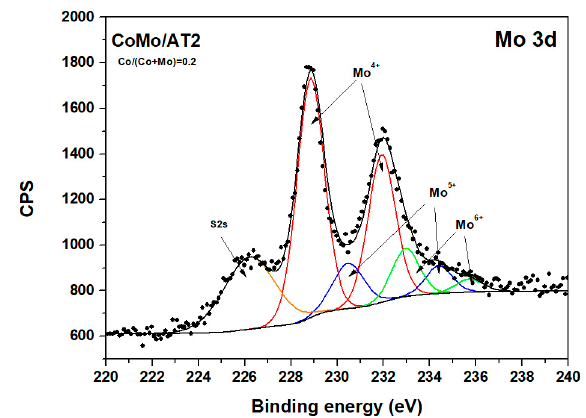
Figure 13. XPS deconvolution of Mo3d core level for sulfided 15 wt.% Mo CoMo / AT2 catalysts at the Co / (Co + Mo) = 0.2 ratio.